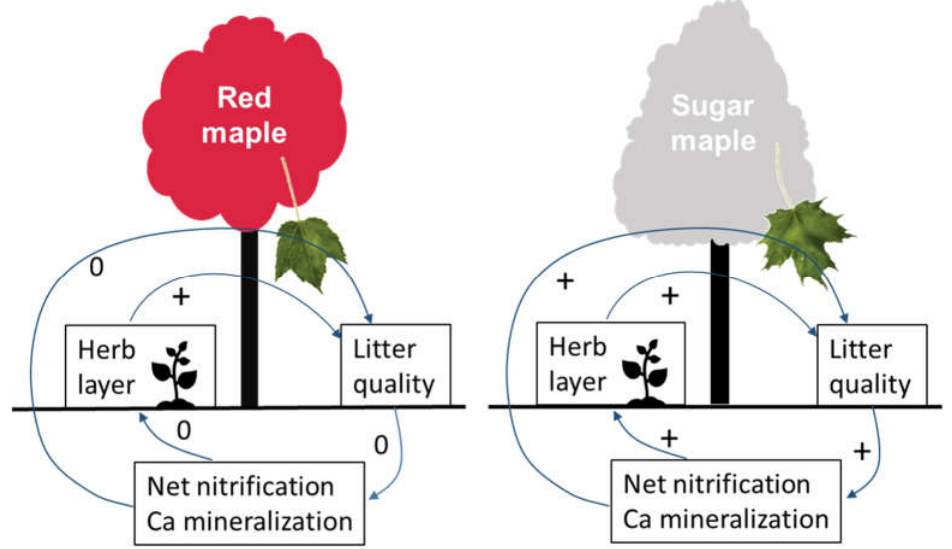
Figure 8. Conceptual diagram of how sugar maple and red maple may affect herb-layer cover through neutrally (0) or positively (+) influencing soil nitrate and calcium through neutrally (0) or positively (+) influencing soil nitrate and calcium availability. Table 4. Average stream water nutrient concentrations at the Fernow Experimental Forest (West Virginia, USA) over a 25- year period (1991–2015) after fertilization began in 1989. The linear regression between stream water nitrate and calcium concentrations yielded an R 2 = 0.99 ( n = 4). SD—standard deviation (based on n = 25 years). Watershed ID Treatment